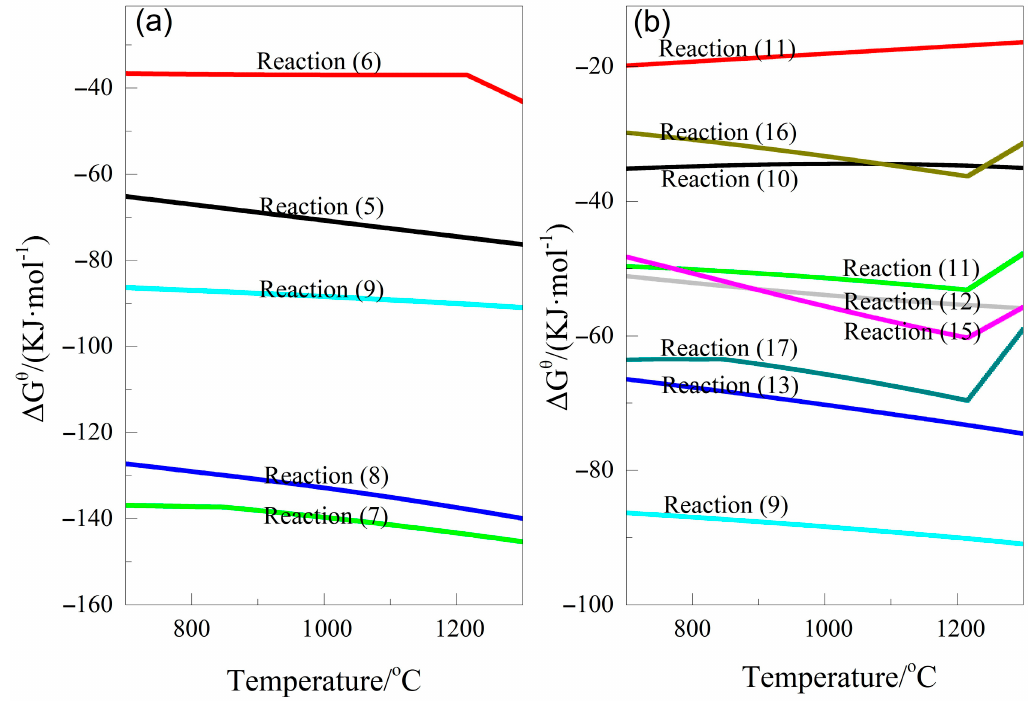
Figure 9. The thermodynamic analysis: ( a ) Free energy change of CaO and oxides versus temperature ( b ) Free energy change of TiO 2 and oxides versus temperature.